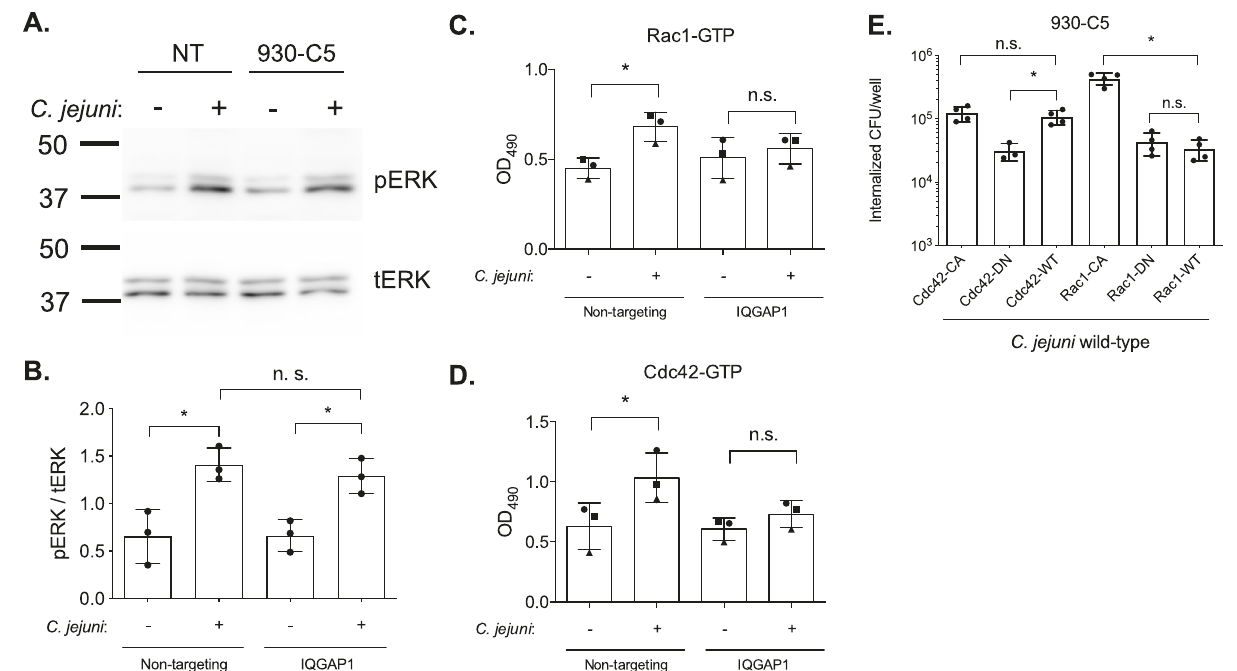
Fig. 4 C. jejuni mediated ERK activation occurs upstream of IQGAP1, while both Rac1 and Cdc42 activation is dependent on IQGAP1. A Human INT 407 cells expressing a non-targeting shRNA (NT) or shRNA targeting the 3 ′ -UTR of IQGAP1 (930-C5) were serum-starved for 4 h, then infected with C. jejuni for 45 min. Samples were collected and analyzed by immunoblot for phosphorylated ERK and total ERK in parallel. A representative immunoblot is shown. Molecular weights are indicated in kDa. B The ratio between the intensity of the phospho-ERK and total-ERK bands were quanti fi ed from three independent biological replicates and plotted. Comparing pERK/tERK in non-targeting shRNA cells with and without C. jejuni p = 0.0069, and in IQGAP1 knockdown cells p = 0.0193. C We observed that in cells expressing non-targeting shRNA there was a robust activation of Rac1 in the presence of C. jejuni , and there was not a signi fi cant amount of activation of Rac1 in the IQGAP1 knockdown cells. Each symbol represents the results from a biological replicate ( n = 3 independent samples). Comparing Rac1-GTP levels in non-targeting shRNA cells with and without C. jejuni, p = 0.0339, and in IQGAP1 knockdown cells p = 0.8751. D A similar trend was observed for the amount of Cdc42 activation, where knockdown of IQGAP1 inhibited C. jejuni -induced Cdc42 activation. Each symbol represents the results from a biological replicate ( n = 3 independent samples). Comparing Cdc42-GTP levels in non-targeting shRNA cells with and without C. jejuni, p = 0.0435, and in IQGAP1 knockdown cells p = 0.7488. E IQGAP1 knockdown cells (930-C5) were transfected with constitutive active (CA), dominant-negative (DN) or wild-type (WT) Cdc42 and Rac1, and the amount of internalized C. jejuni was measured in each condition using a gentamicin protection assay ( n = 4 independent samples). The following comparisons were made on log-transformed counts: Cdc42-CA to Cdc42-WT ( p = 0.9650), Cdc42-DN to Cdc42-WT ( p = 0.0002), Rac1-CA to Rac1-WT ( p = <0.0001), Rac1-DN to Rac1-WT ( p = 0.7861). For all charts, bars represent the mean and error bars represent the standard deviation; signi fi cant differences were determined by ANOVA followed by a two-tailed Sidak ’ s multiple comparisons test (* p <